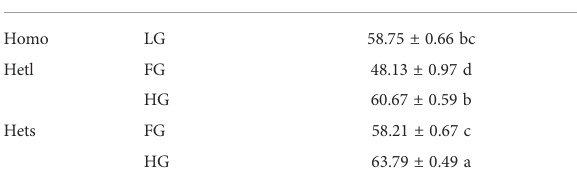
TABLE 1 The root mycorrhizal colonization rate of B. pilosa under the inoculated treatments. Treatments